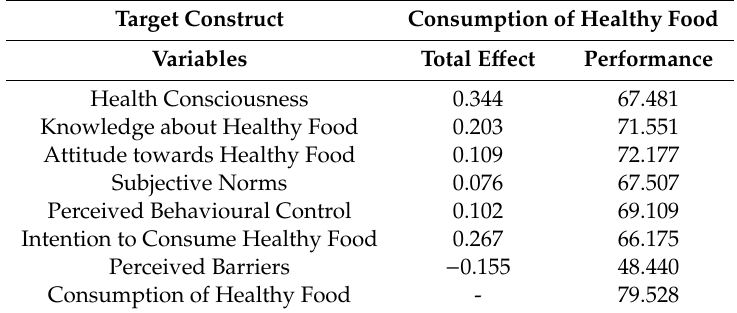
Figure 2. Importance performance map. Table 8. Performance and total e ff